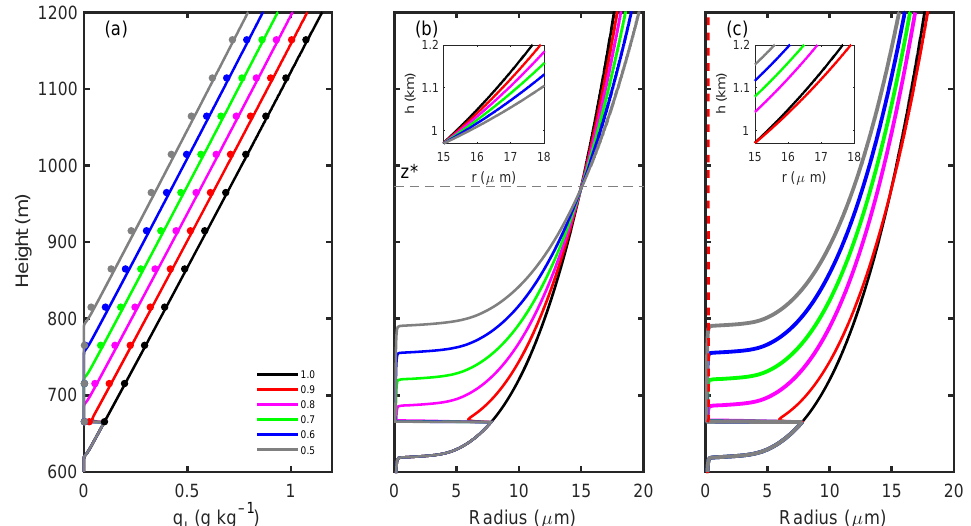
Figure 1. (a) Liquid water mixing ratio profiles for various cloud mixing fractions χ and with low updraft speed (0 . 1ms − 1 ). Lines are from the parcel model and dots are from the theoretical prediction given by Eq. (17). (b) Cloud droplet radius vs. height for various χ when mixing with clean (aerosol-free) environmental air. The horizontal dashed line represents the critical height z ∗ calculated from Eq. (20). (c) Cloud droplet radius vs. height for various χ when mixing with polluted environmental air (air containing CCN similar to cloud base conditions). Insets in panels (b) and (c) show details of the radius profiles above the critical height. Super-adiabatic droplet growth, i.e., droplet diameters greater than in the unmixed cloud ( χ = 1 . 0), is observed for all χ in panel (b) and only for χ = 0 . 9 in panel (c)